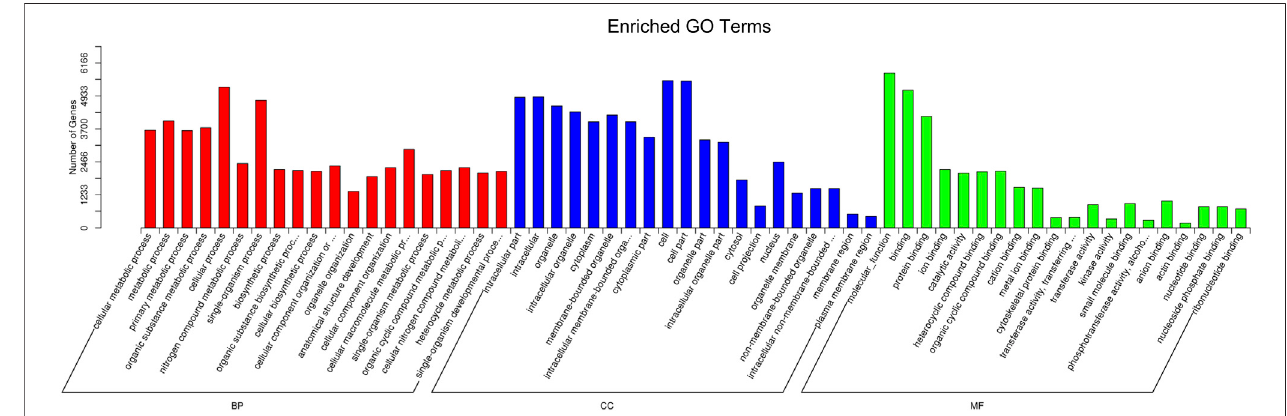
FIGURE 5 | GO function classi fi cation target genes of known differential expressed miRNAs in K562 cells after CAP treatment. Abscissa: class classi fi cation. The three different classi fi cations represent the three basic classi fi cations of GO terms. From left to right, they are biological process (BP), cellular component (CC), and molecular function (MF).